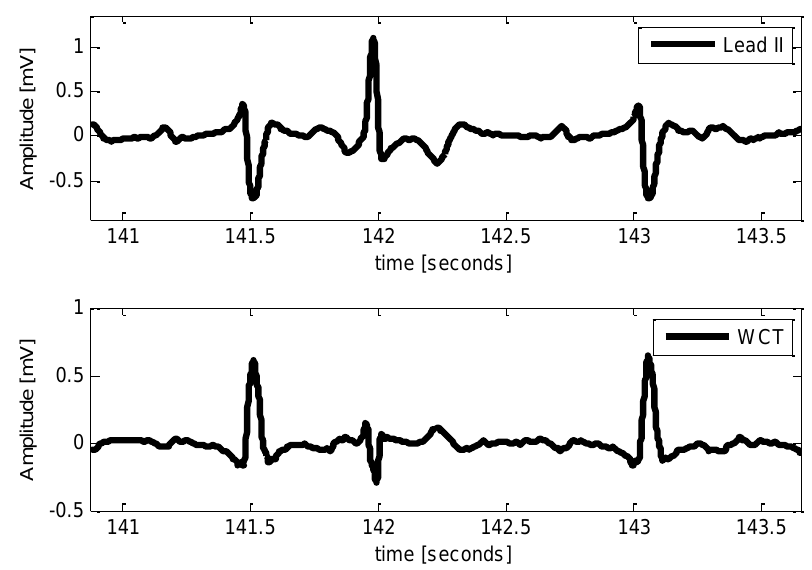
Figure 8. Example of positive WCT that mutates into negative during an ectopic beat (noted by the arrow). WCT amplitude also varies from 65% of lead II amplitude (average) to 33% of lead II during the ectopic beat; recording is from a 79-year-old male patient admitted due to arrhythmia.